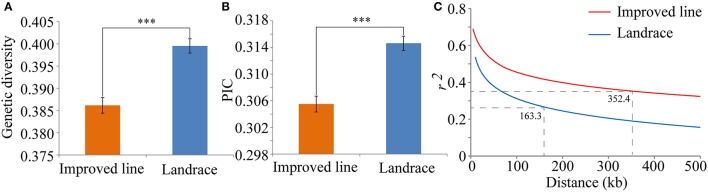
Characteristics of SNP diversity and genome-wide average LD decay in two panels. (A) Genetic diversity of SNPs in the improved lines and landraces. (B) Polymorphism information content in the improved lines and landraces. (C) Estimation of genome-wide average LD decay distances from the improved line (red) and landrace panels (blue). The dashed line represents the LD decay rate, which was measured as the chromosomal distance at which the average pairwise correlation coefficient (r2) dropped to half of its maximum value. ***P = 0.001.